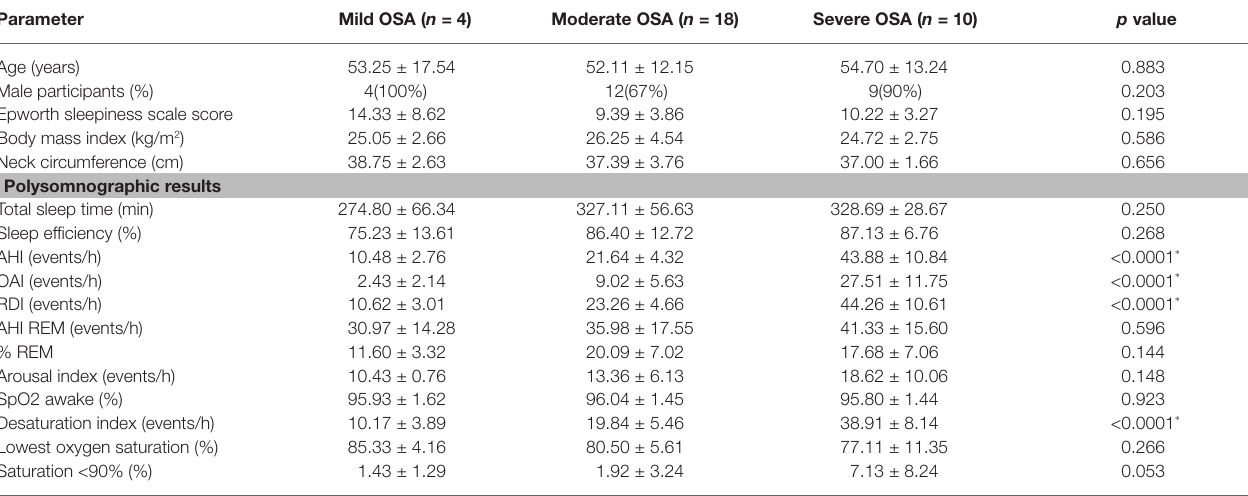
TABLE 2 | Data of polysomnography in participants with obstructive sleep apnea. Parameter